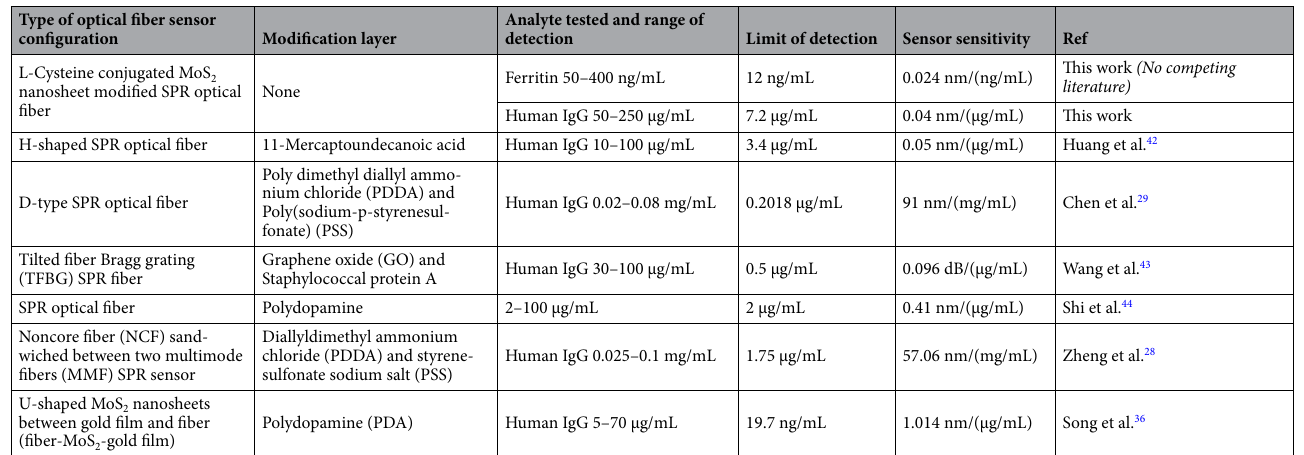
Table 1. Evaluation of the performance of Ab(Ft)/L-Cysteine/MoS 2 /OF-SPR and Ab(IgG)/L-Cysteine/MoS 2 / OF-SPR biosensors with respect to the recently reported similar